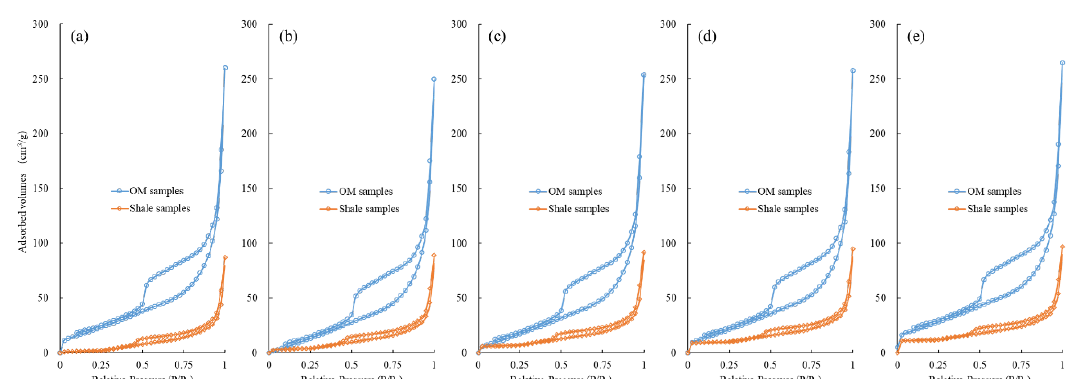
Figure 4. Comparison of low-pressure N 2 adsorption isotherms of isolated OM and bulk shale samples. From left to right, TOC content of the samples increased; ( a ) J4-1 sample; ( b ) J4-2 sample; ( c ) J4-3 sample; ( d ) J4-4 sample; ( e ) J4-5 sample.